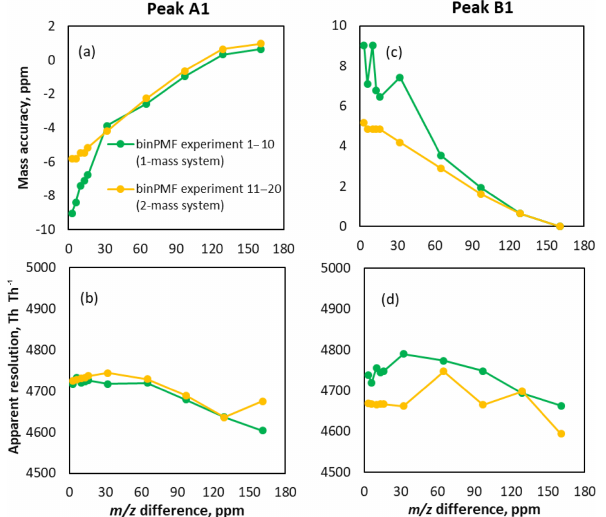
Figure 5. Characteristics of peaks fitted to binPMF factors. Pan- els (a) and (b) show results for peak A1 and (c) and (d) for peak B1. In panels (a) and (c) , the mass accuracy of peaks resolved by binPMF is compared to the original data. Panels (b) and (d) de- pict the resolution of the two fitted peaks. The original resolution of the input data was 5000ThTh − 1 .